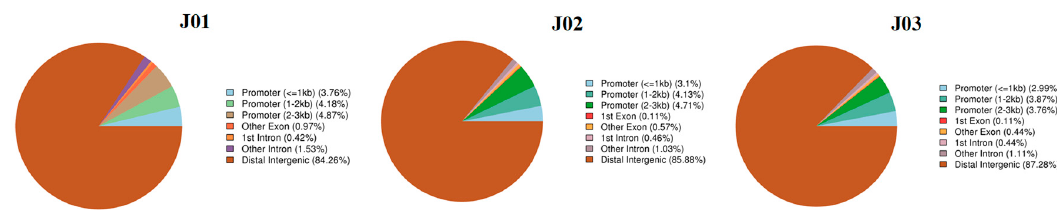
Figure 5. The annotation of the hypermethylated CpG islands (CGI) regions in different samples. More than 84% of the hypermethylated CGI regions were distributed in the distal intergenic regions and about 10% were distributed in the promoter region.